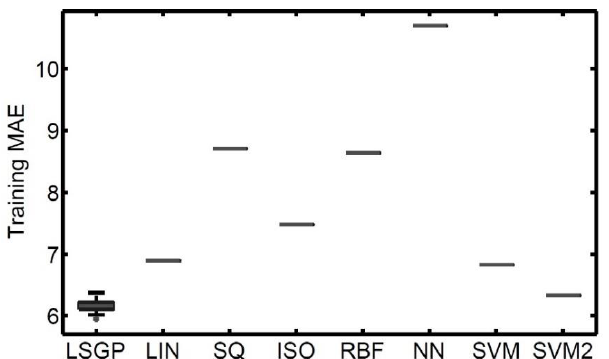
Figure 4. Boxplots of the training MAE calculated over 100 runs. On each box, the central mark is the median, the edges of the box are the 25th and 75th percentiles, and the whiskers extend to the most extreme data points not considered outliers. The MAE is expressed in Euros. LIN stands for linear regression, SQ stands for ordinary least square regression, ISO stands for isotonic regression, RBF stands for radial basis function network, NN stands for multilayer perceptron trained with backpropagation, and SVM stands for support vector machine with a polynomial kernel (of second degree for SVM2).